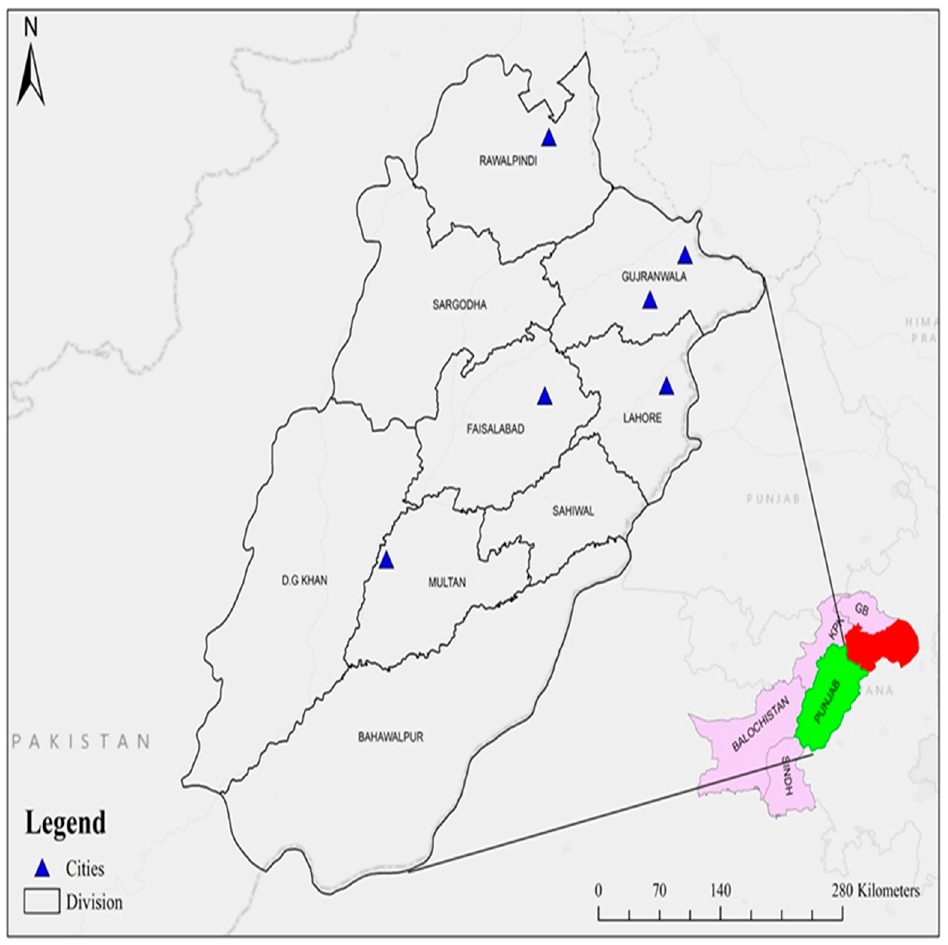
Figure 1. Punjab map with selected cities. Table 1. Area, population, and population density of selected cities (according to the 2017 census) .